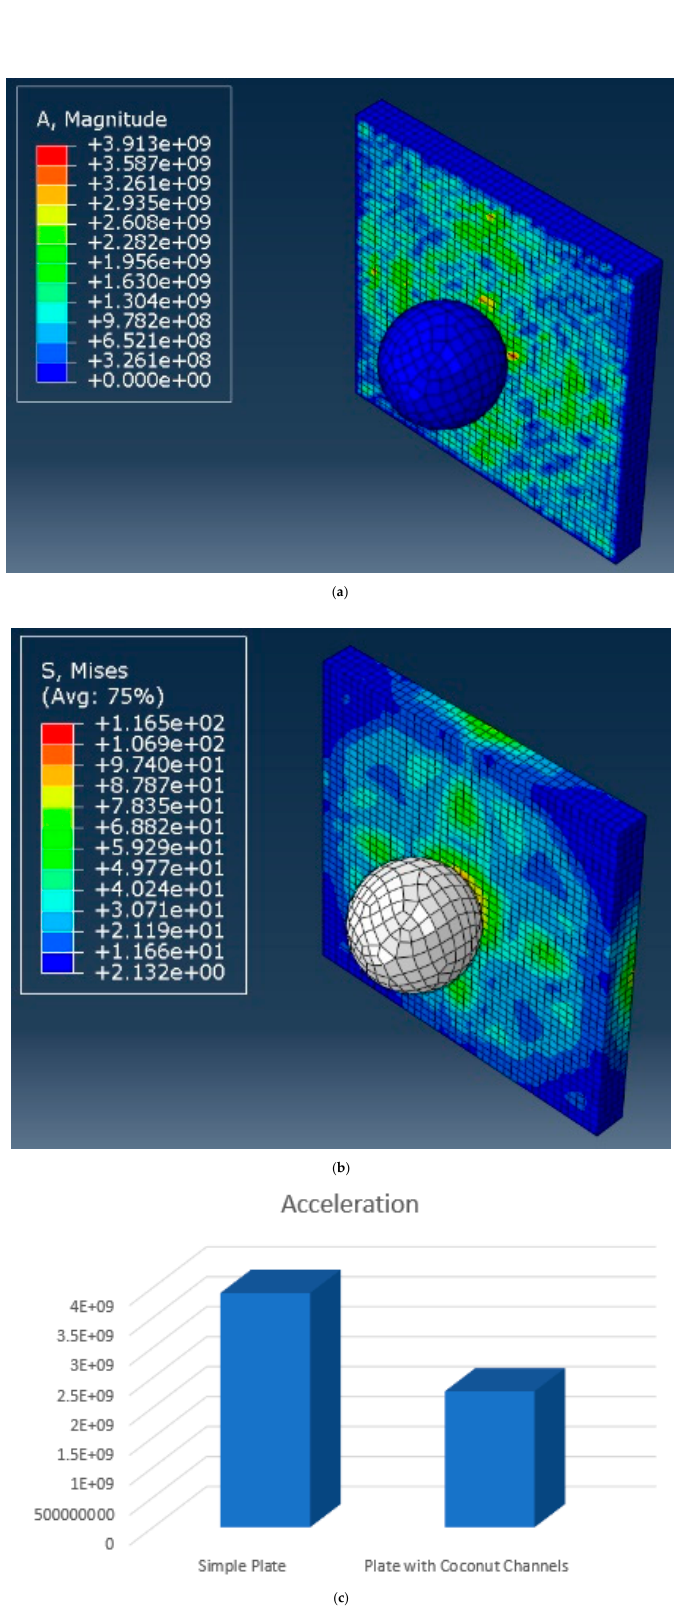
Figure 12. Comparison between a coconut-inspired plate and a regular plate with respect to impact performance. (In the scientific notation, 3.913e+09 or 3.913E+09 represents 3.913 × 10 9 ; other floating values follow the same rule.) ( a ) Distribution of acceleration ( m/s (cid:2870) ) ; ( b ) Distribution of von Mises stress ( N/mm (cid:2870) ); ( c ) Acceleration reduction.